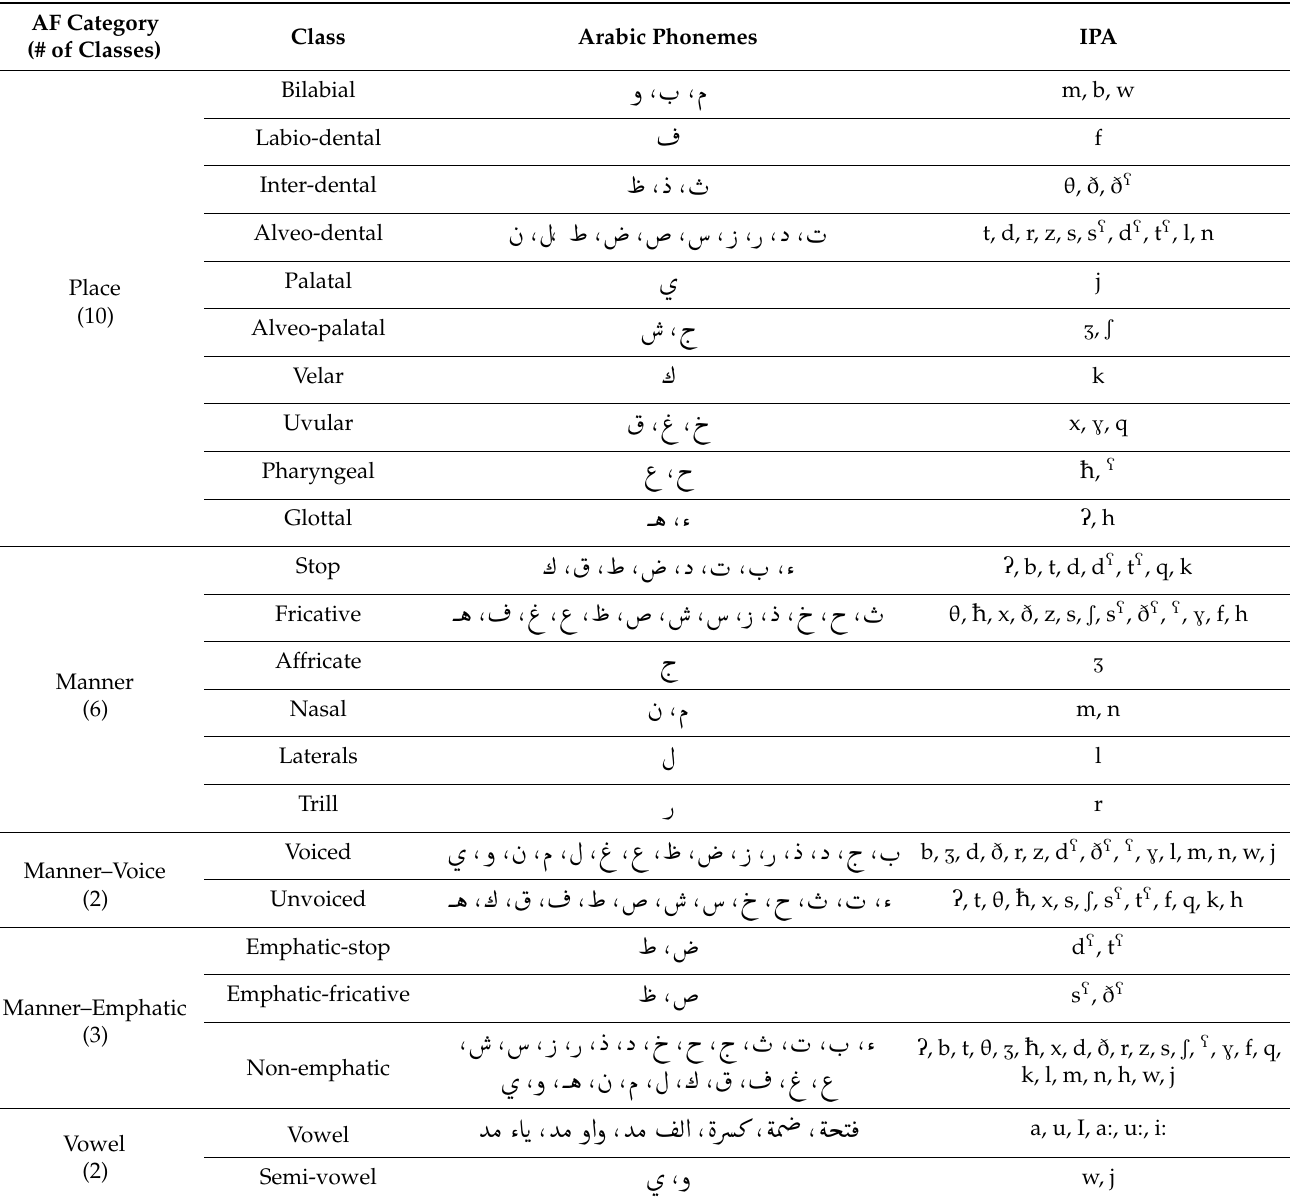
Table 4. AF categories, classes of each category, and phonemes and their IPA of each class used in this study.